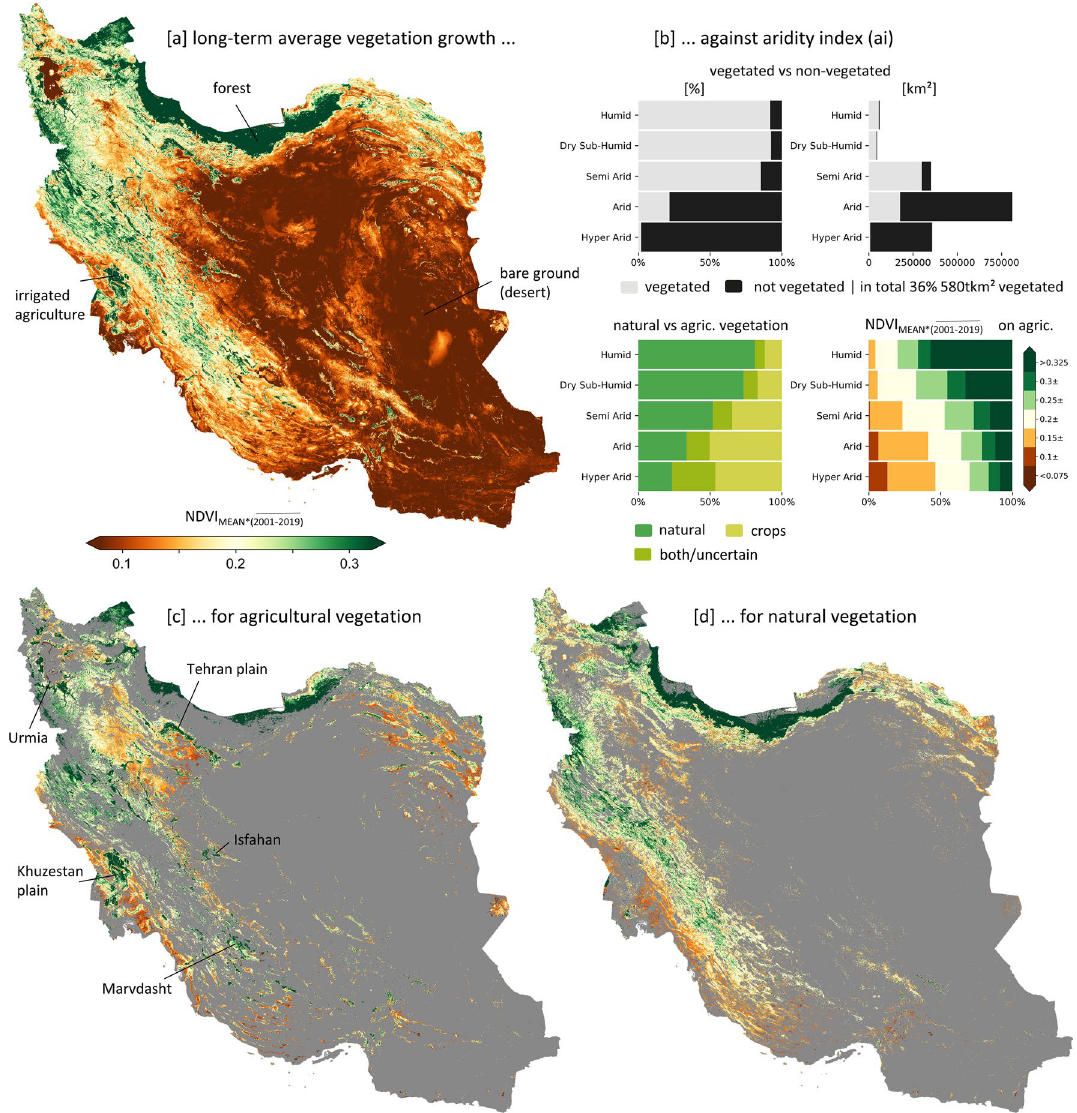
Figure 4. Long-term vegetation growth, i.e. average of the annual vegetation growth ( NDVI MEAN ∗ ) between 2001 and 2019. ( a ): Long-term vegetation growth for entire Iran. ( b ): Vegetation specific statistics related to the aridity index ( ai ). Upper panel: vegetated versus not vegetated areas. Lower left panel: share of natural and agriculture vegetation. Lower right panel: Long-term vegetation growth distribution for agricultural areas. ( c ): Long-term vegetation growth for agricultural vegetation, indicating the locations of some large irrigation networks. ( d ): Long-term vegetation growth for natural vegetation. General Notes: Agricultural areas are identified by the recent global land cover map of Copernicus Global Land Service (Methods). Natural vegetation is defined as being no agricultural land and where the NDVI exceeds 0.25 in at least two water years (Methods). Maps were created using Python 3.9 (https:// www. python.